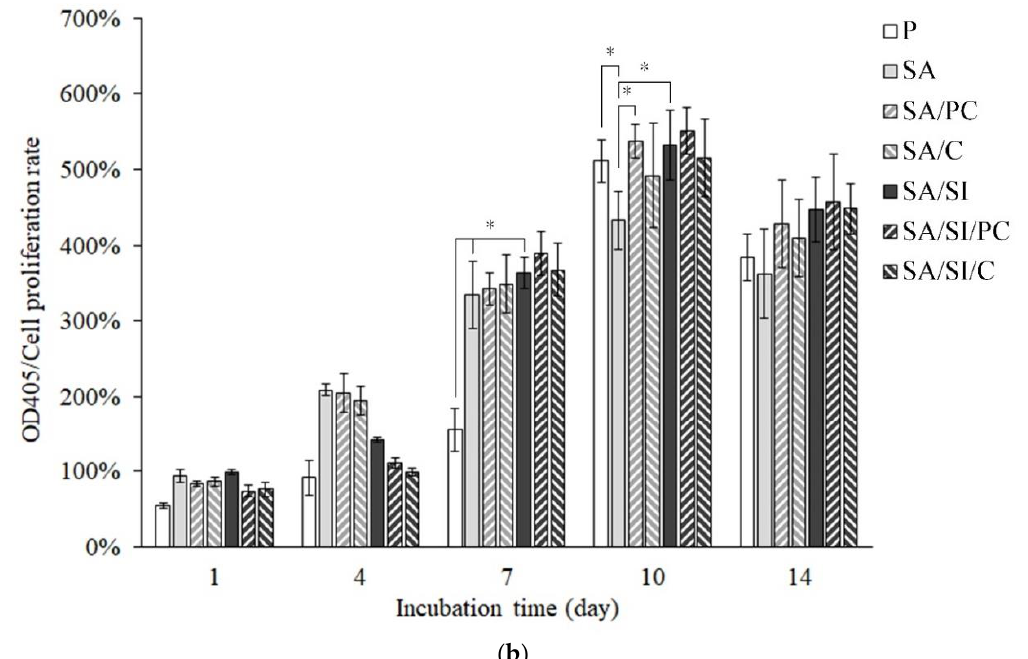
Figure 10. Progenitor bone cells of D1 were cultured on surface-modified PEEK for 1, 4, 7, 10, and 14 days: ( a ) total amount changes in ALP activity and ( b ) adjusted ALP activity in the unit cell ( n = 6). Character symbols * indicate that each testing group after one-way ANOVA is significantly different ( p < 0.05).